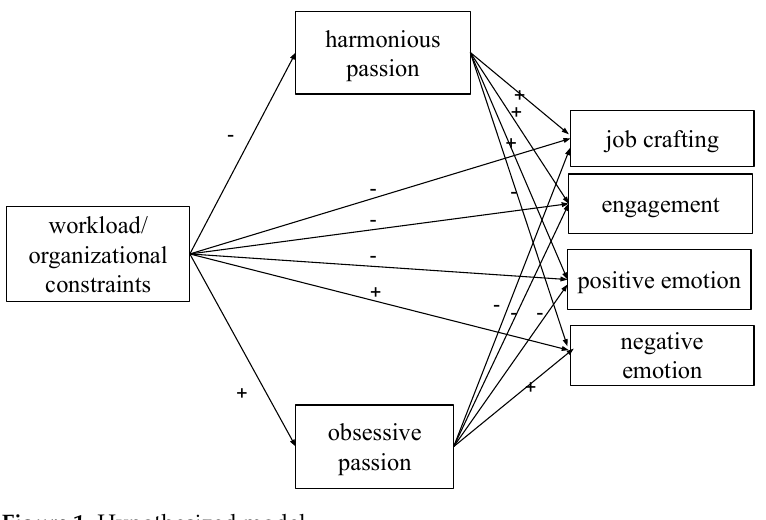
Figure 1. Hypothesized model.